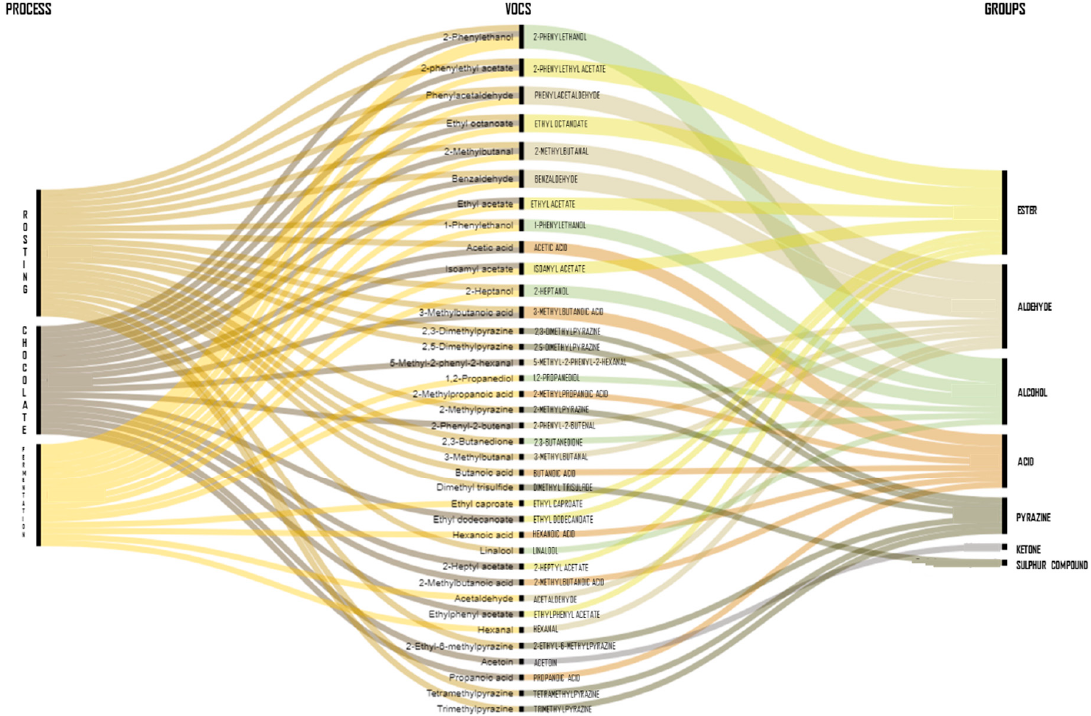
Figure 2. Most identified and abundant volatile compounds in fermented and roasted cocoa beans and